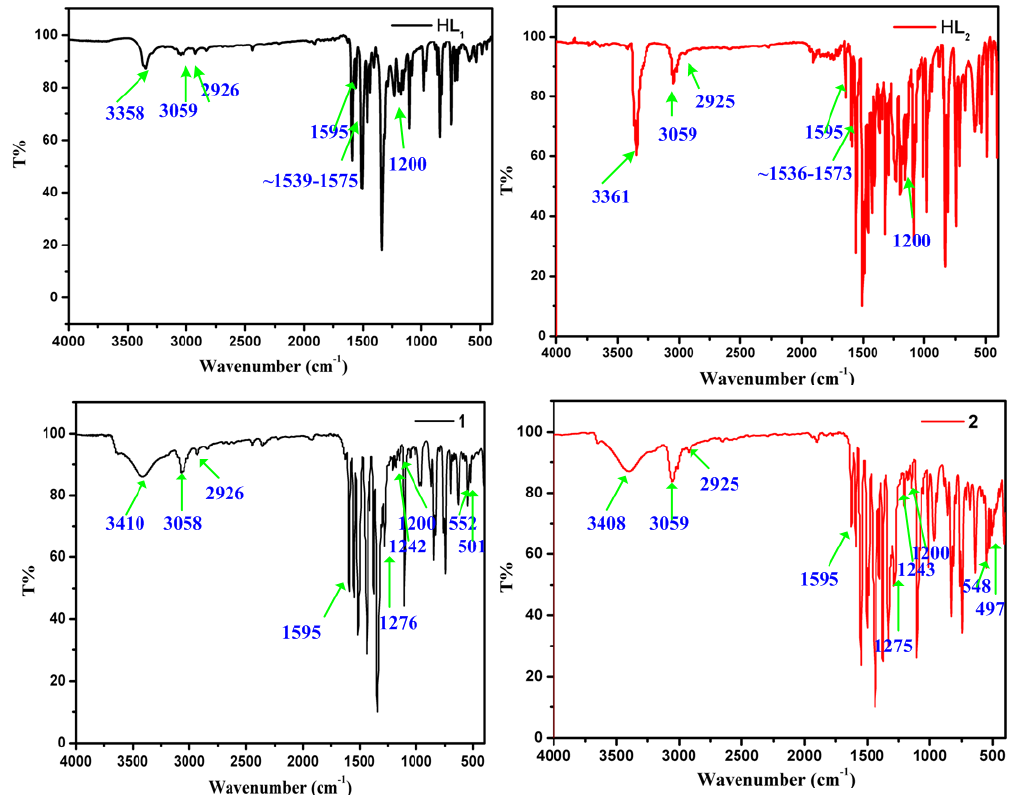
Figure 8. Infrared spectra of free ligands, complexes 1 and 2 . Table 3. Infrared spectral bands and assignments of two Cr-based